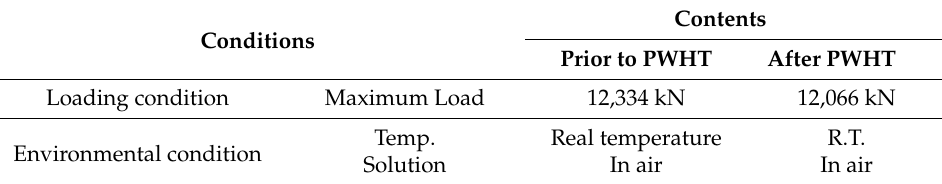
Figure 9. Corrosion fatigue test results comparison of prior to and after PWHT. Table 8. Tests conditions for fatigue crack growth rate.